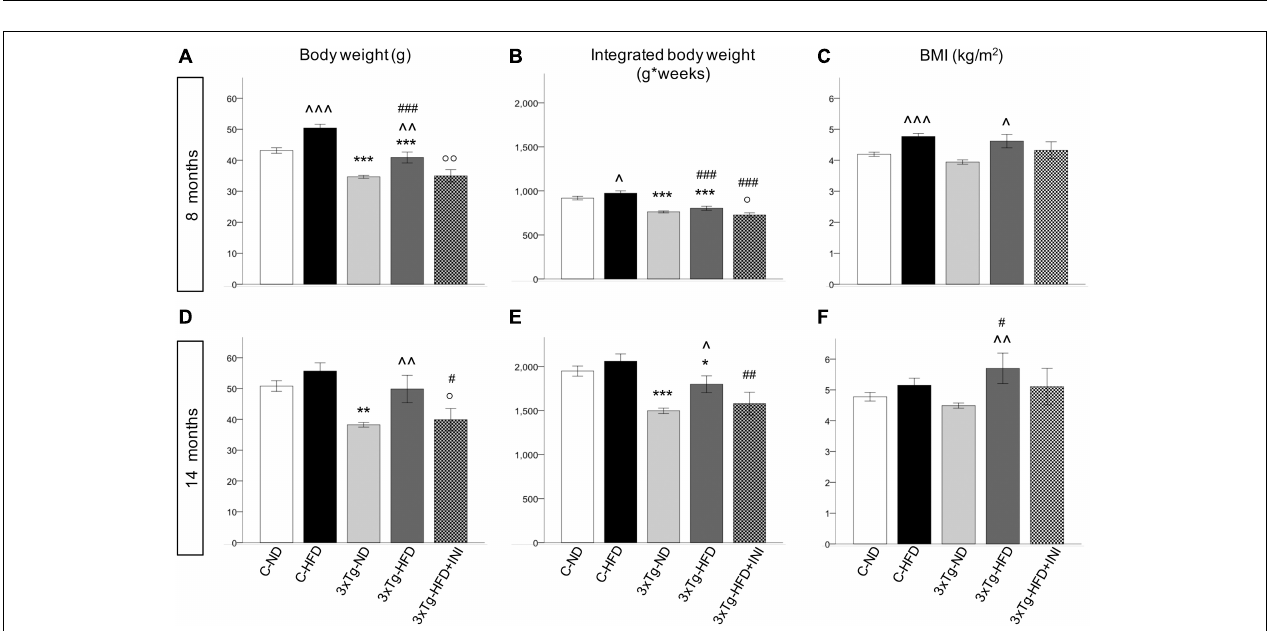
FIGURE 3 | Body weight, areas under the curves and BMI achieved by the study groups at final time-points of 8 (A–C) and 14 months of age (D–F) , showing that body weight was affected by diet (positively) and by 3 × Tg background (negatively), whereas BMI was only dependent on diet, since 3 × Tg mice were lighter, but also shorter (data not shown) than controls. Data are presented as mean ± SEM. Sample sizes are given in Table 1 . ∗ p < 0.05 or less ( ∗∗ , ∗∗∗ ) ND-ND and HFD-HFD (between strains), ∧ p < 0.05 or less ( ∧∧ , ∧∧∧ ) HFD vs. ND (within-strain), # p < 0.05 or less ( ## , ### ) vs. ND control group (reference group), ◦ p < 0.05 or less ( ◦◦ ) for treated 3 × Tg-HFD + INI vs. untreated 3 × Tg-HFD.